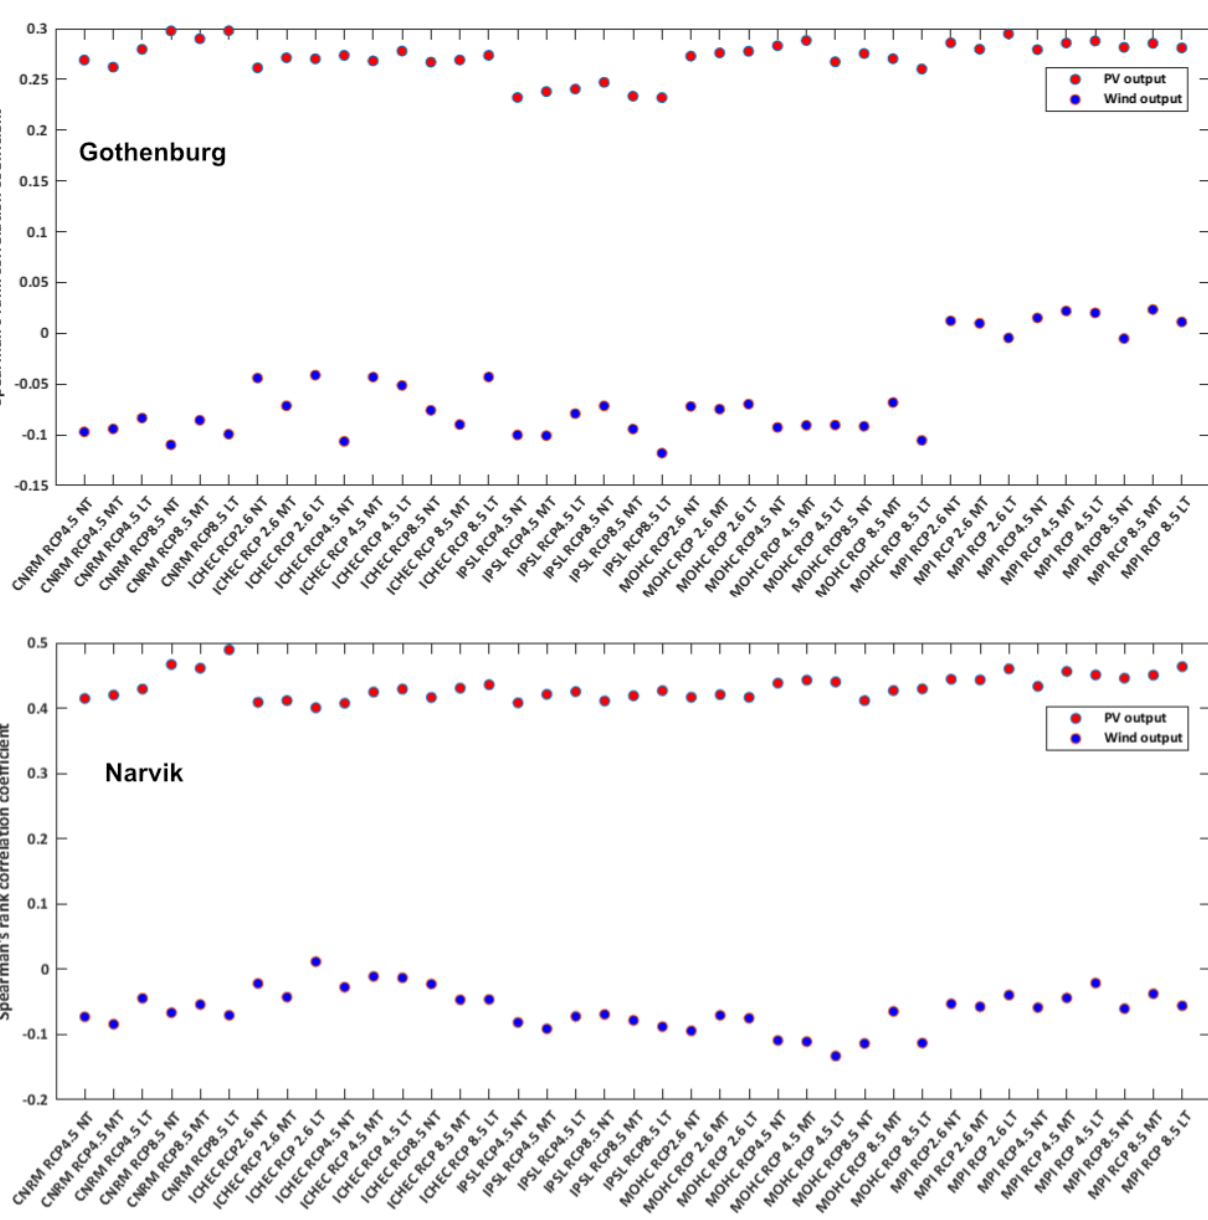
Figure 6. Spearman’s correlation between temperature and solar or wind output (Gothenburg and Narvik).